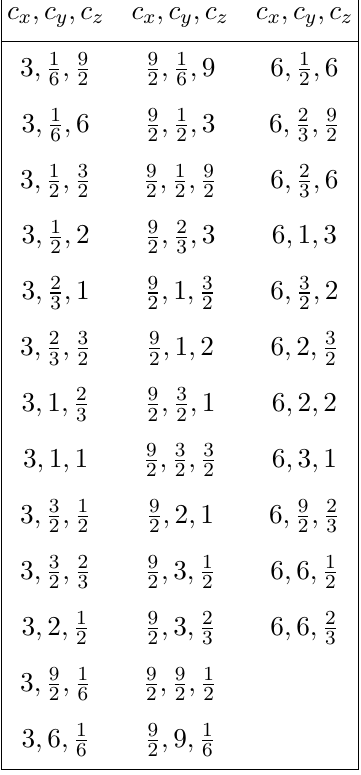
Table 1 . The list of all combinations of SU(5) Clebsch-Gordan coe(cid:14)cients (only absolute values), which provide the Yukawa double ratio y (cid:22) y d values of these coe(cid:14)cients were taken from the classi(cid:12)cation in [4,